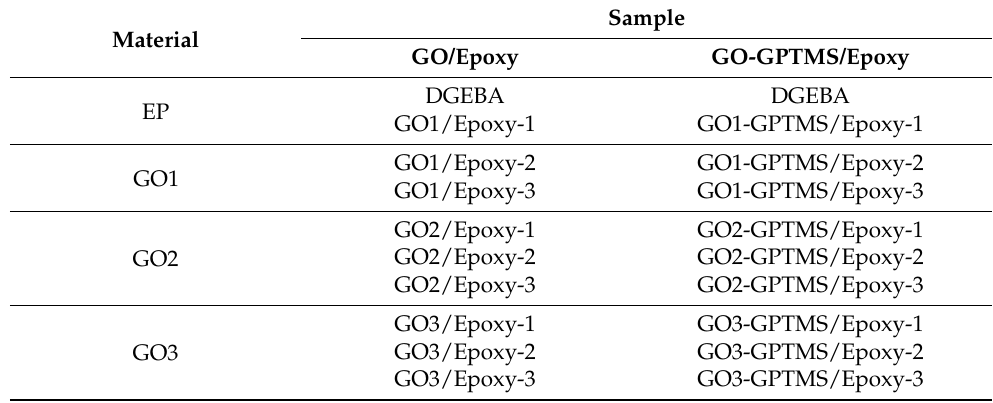
Table 2. Working nomenclature